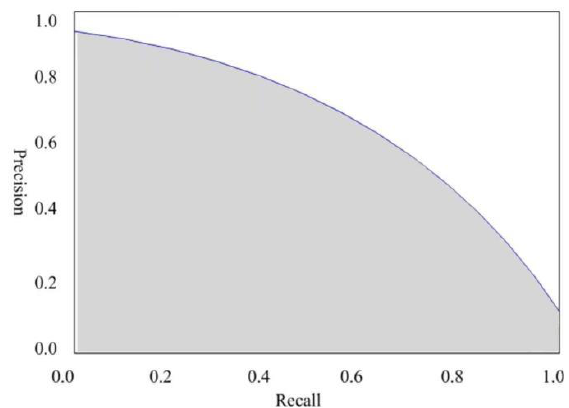
Figure 9. P-R curve diagram.